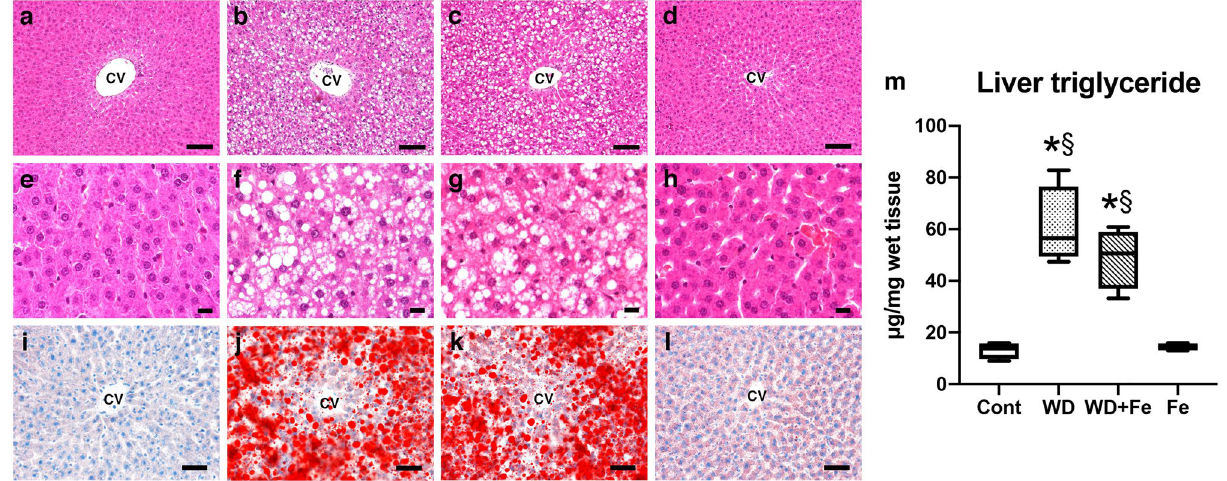
Figure 2. Histopathology of the liver in ( a ) control, ( b ) WD, ( c ) WD + Fe and ( d ) Fe groups at week 26. CV: central vein. Bar: 100 µm. ( e – h ) Higher magnification of a - d , respectively. Bar: 15 µm. Oil red O-stained sections in the liver of ( i ) control, ( j ) WD, ( k ) WD + Fe, and ( l ) Fe groups at week 26. Bar: 50 µm. ( m ) Hepatic triglyceride content at week 26. Data are presented as box and whiskers (n = 4/group). * P < 0.05 versus Cont, and § P < 0.05 versus Fe by one-way ANOVA followed by Tukey’s multiple of total IRS1 did not differ significantly between all groups (Fig. 5a) while tyrosine phosphorylation in IRS1 (Tyr612) decreased in WD ( P = 0.0002 vs. Cont and P < 0.0001 vs. Fe) and WD + Fe ( P = 0.0002 vs. Cont and P = 0.0087 vs. Fe) groups compared with Cont and Fe groups (Fig. 5b). Expression of total and phosphorylated Akt2 also decreased in WD (total Akt2; P = 0.0027 vs. Cont and P = 0.0259 vs. Fe, phosphorylated Akt2; P = 0.007 vs. Fe) and WD + Fe (total Akt2; P = 0.0002 vs. Cont and P = 0.0013 vs. Fe, phosphorylated Akt2; P = 0.0272 vs. Cont and P = 0.0002 vs. Fe) (Fig. 5c, d). Nuclear translocation of FOXO1 did not change significantly between the four groups (Fig. 5e, f). Additionally, hepatic expression of Pck1 and G6pc genes was downregulated in WD and WD + Fe groups (Supplementary Fig. S3a, b). These data suggest that insulin signal pathway is at least partly altered in the liver of WD and WD + Fe groups.